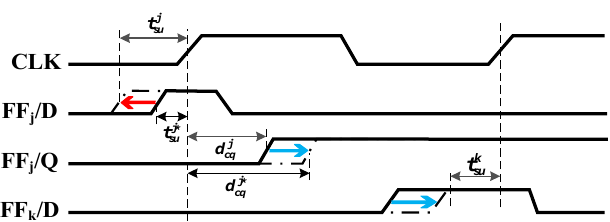
Figure 4. Fix timing violation with independent timing model for flip ‐ flop.